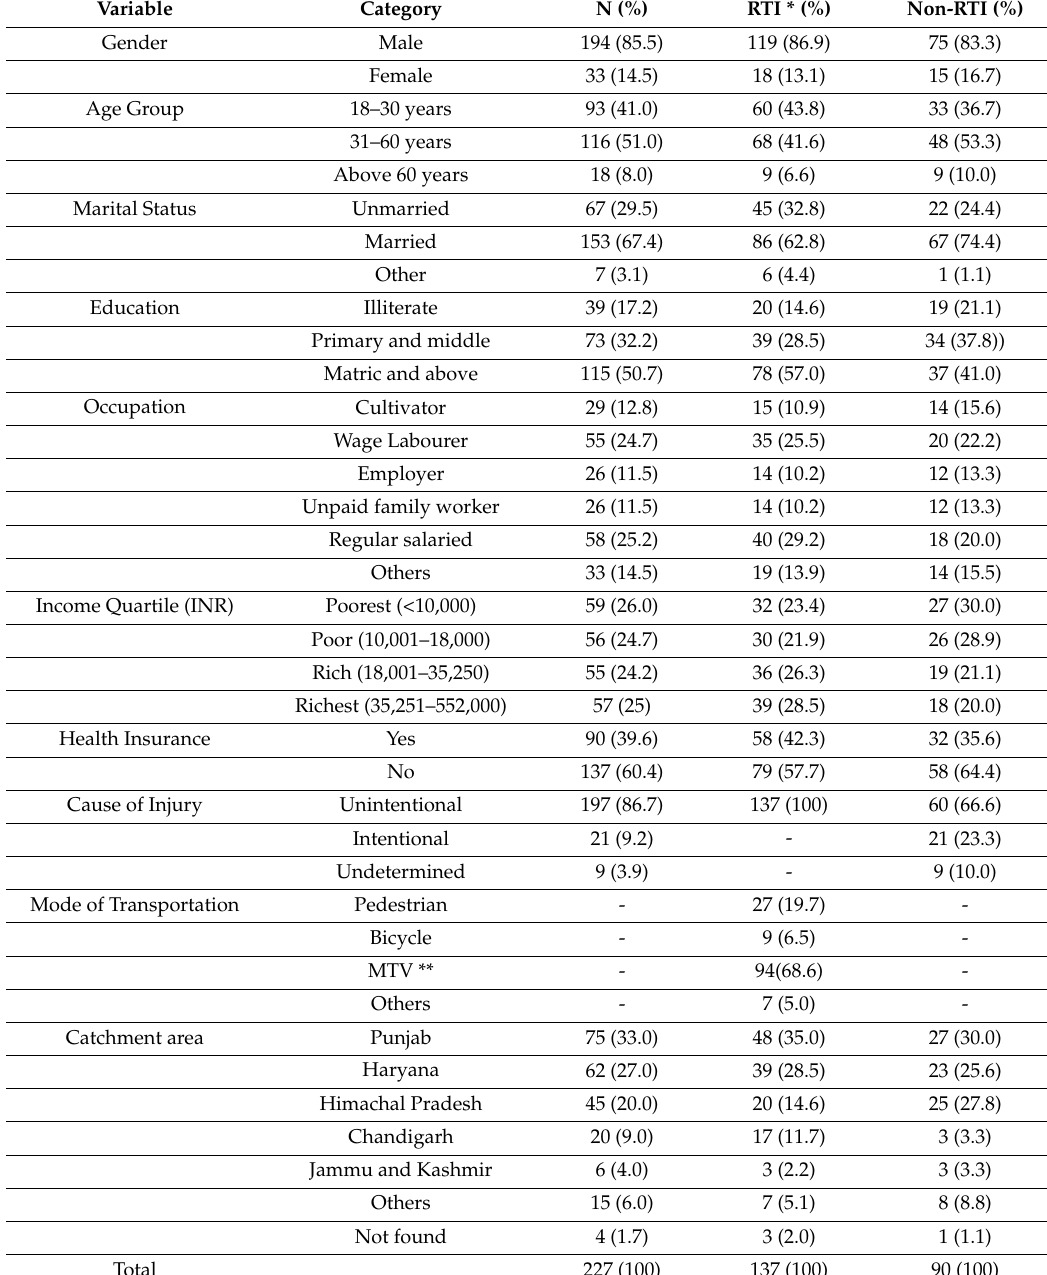
Table 1. Socio-demographic characteristics of hospitalised injury